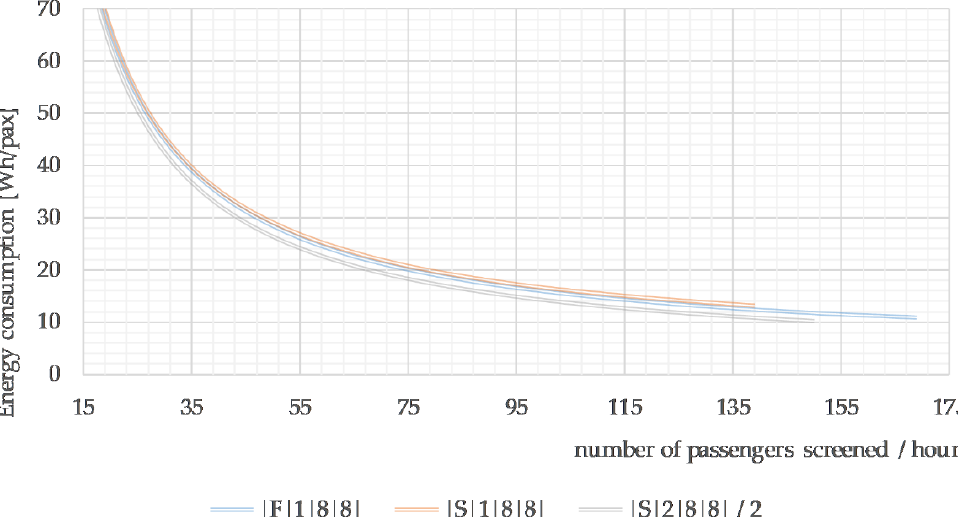
Figure 5. The amount of power consumed per passenger as a function of the number of passengers screened per hour.